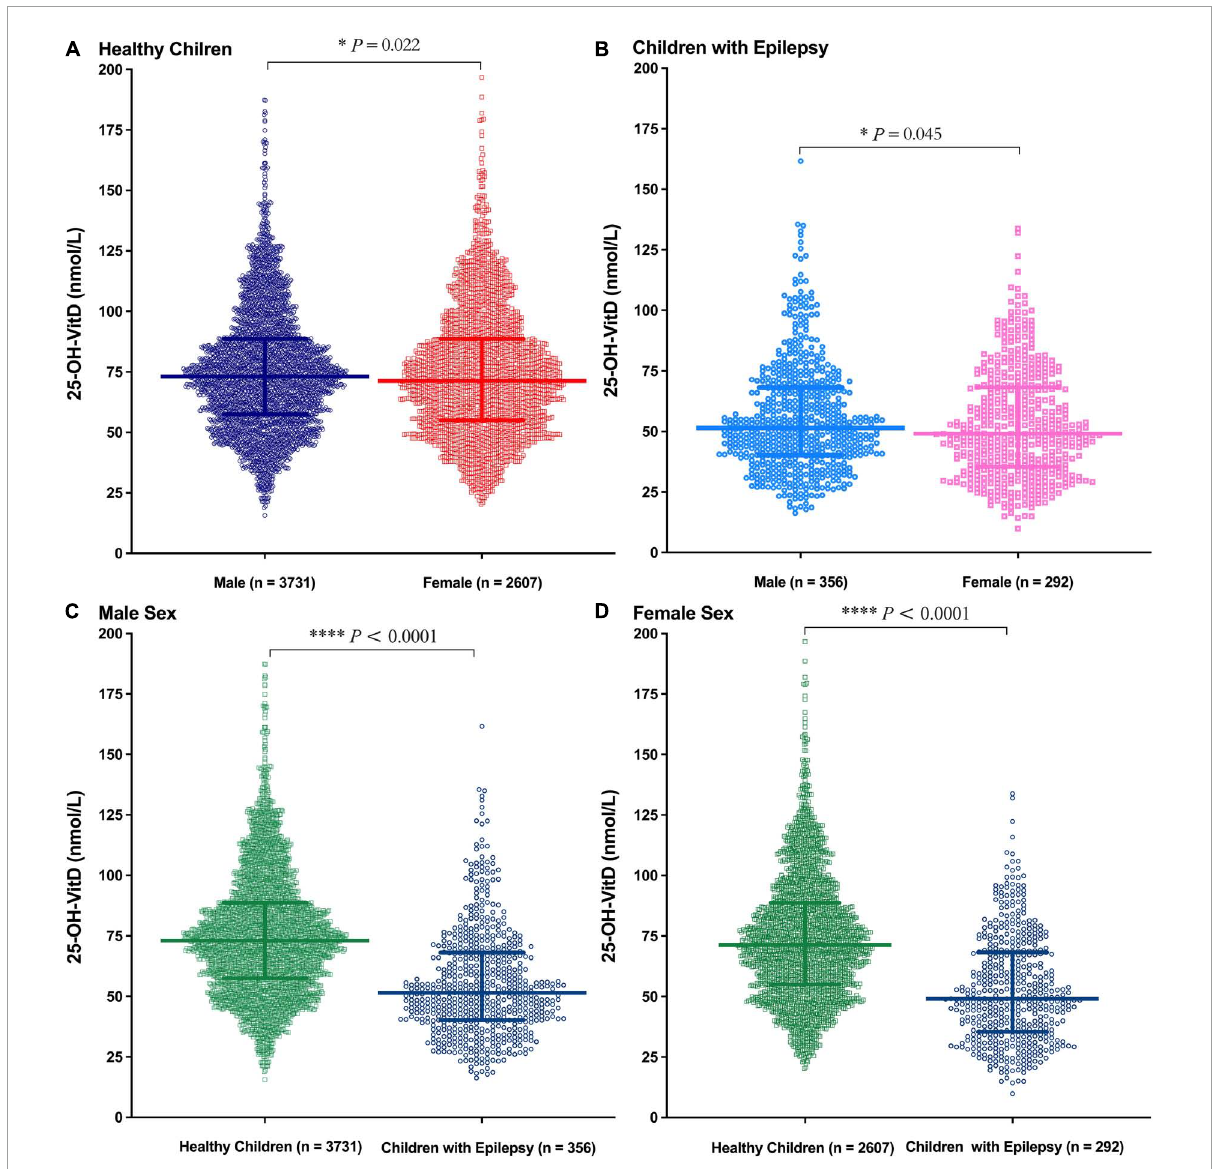
FIGURE4 Comparison in serum 25-OH-VitD status of subjects with different sex (Male and Female). (A) Comparison in serum 25-OH-VitD status between males and females of healthy children. (B) Comparison in serum 25-OH-VitD status between males and females of children with epilepsy. (C) Comparison in serum 25-OH-VitD status between healthy children and children with epilepsy among male sex. (D) Comparison in serum 25-OH-VitD status between healthy children and children with epilepsy among female